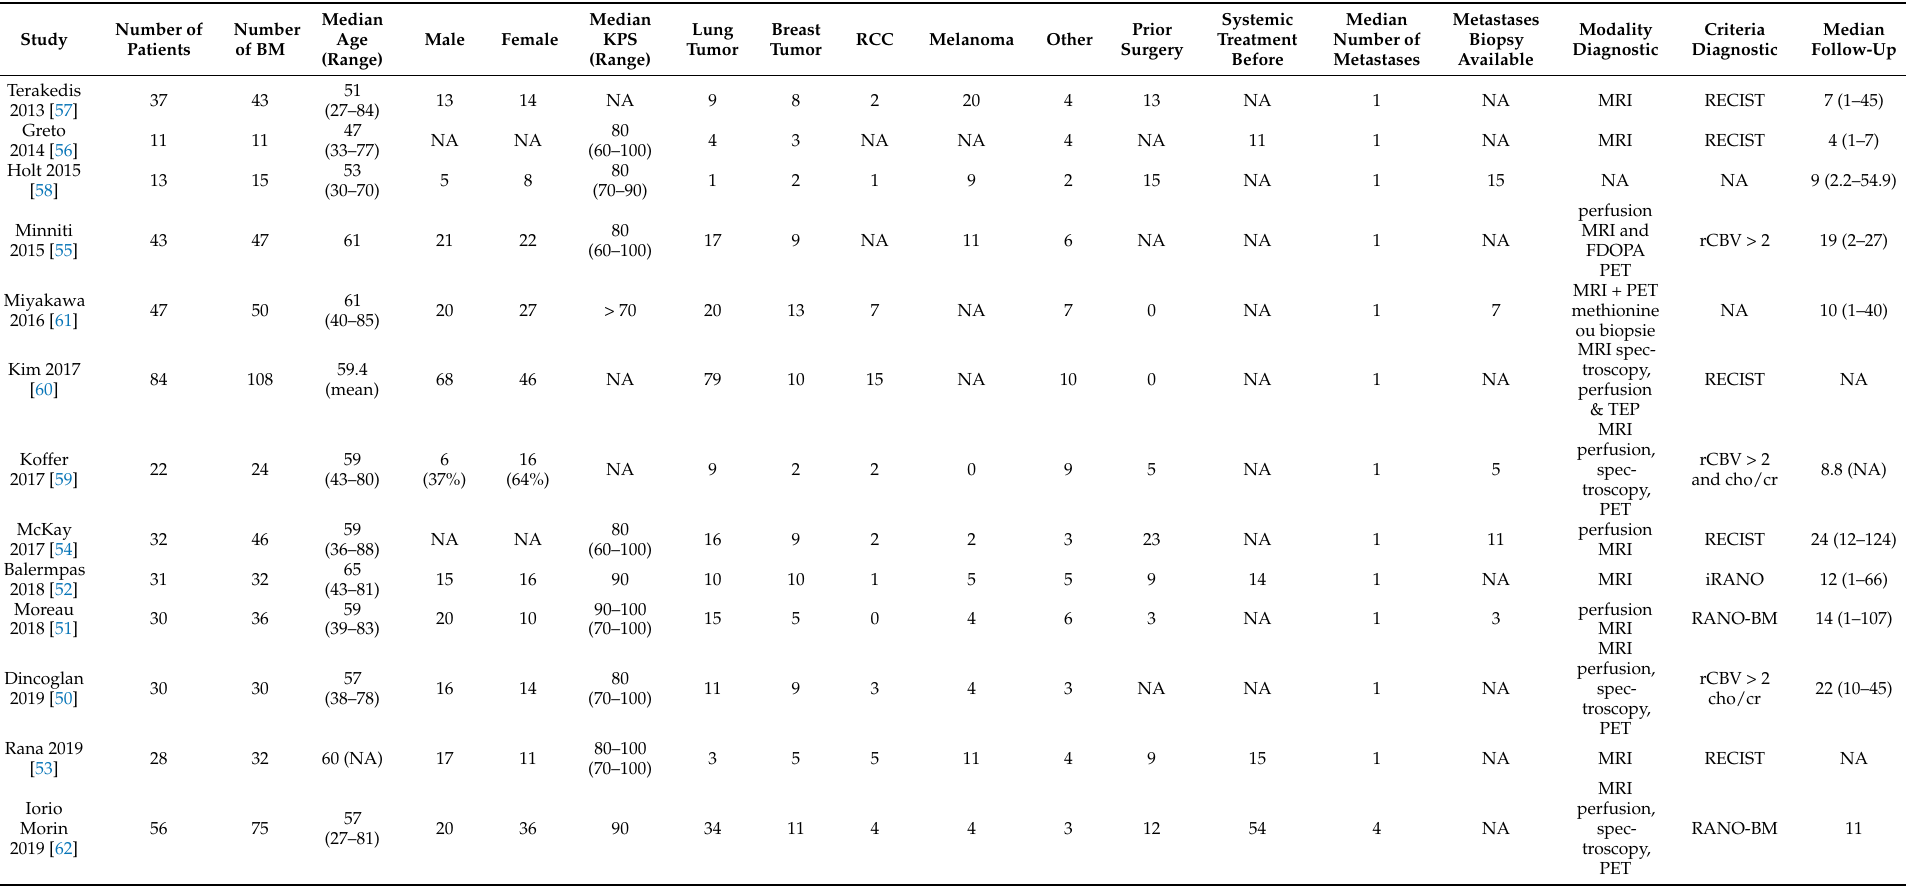
Table 2. Summary of clinical